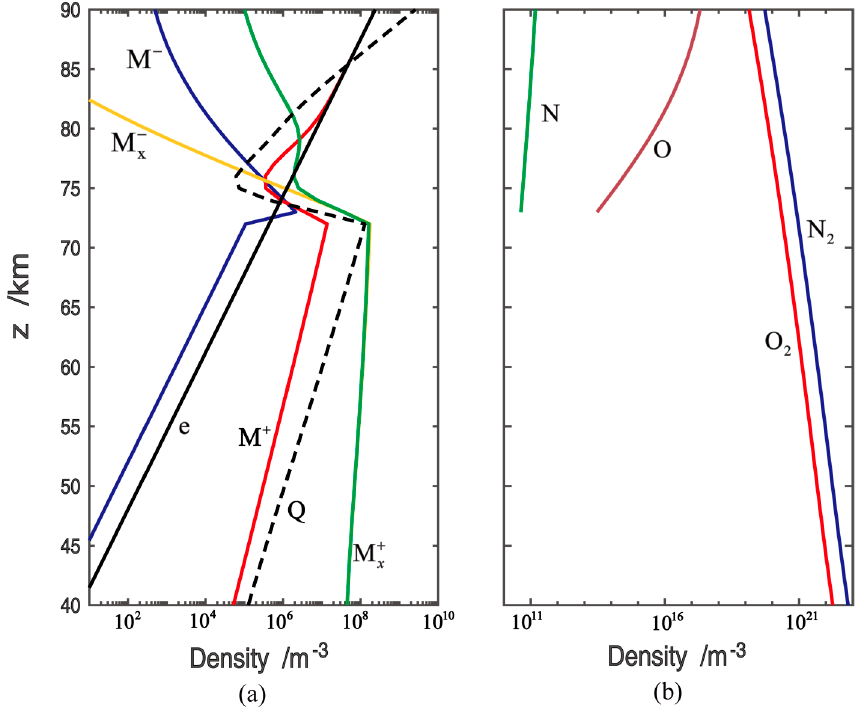
Figure 6. Background profile of various particles: ( a ) charged particles and radiation source Q, and ( b ) neutral particle composition (taken from NRLMSISE-00).